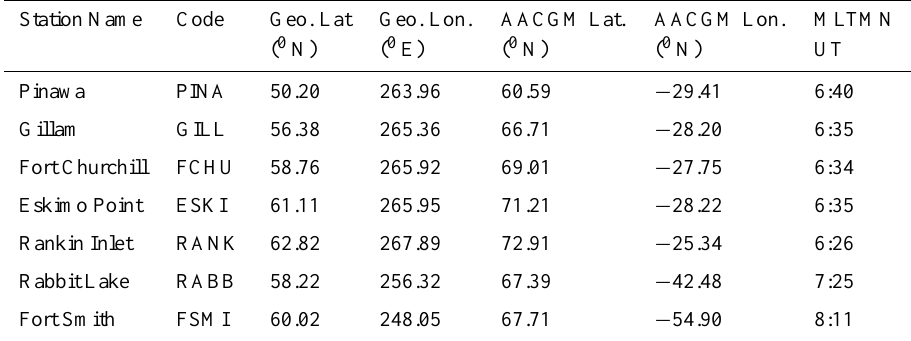
Table 1. Magnetometer stations used in this